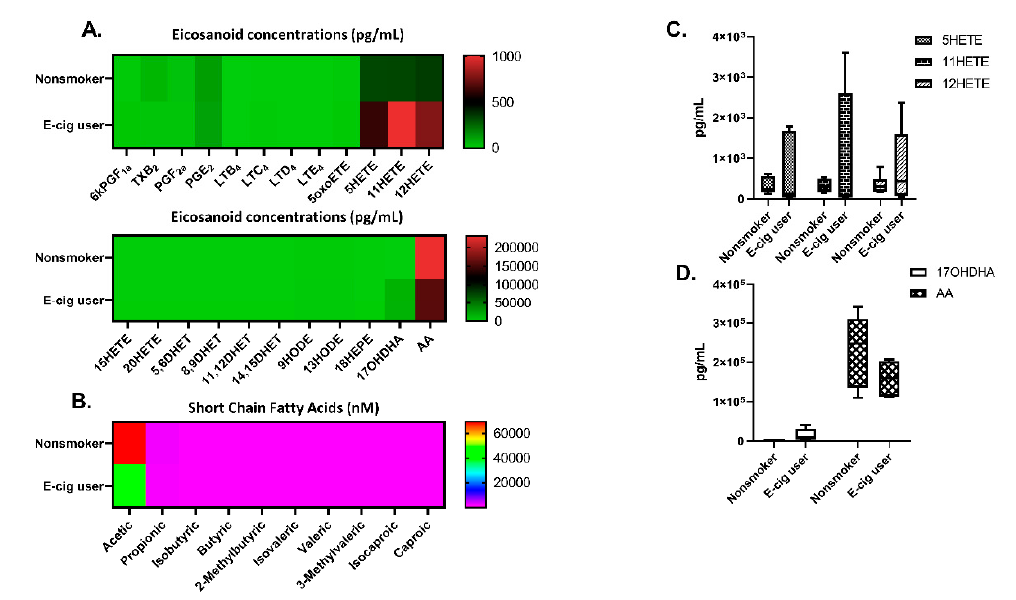
Figure 9. Plasma eicosanoids, oxylipins, short-chain fatty acids in nonsmokers and e-cig users. ( A ) Heat map generated from relative quantification by LC-MS / MS of eicosanoids, oxylipins, and ( B ) short-chain fatty acids in plasma from nonsmokers and e-cig users. ( C ) 5HETE, 11HETE, and 12HETE levels in plasma ( D ) 17OHDHA and AA in plasma ( n = 6 / group). p > 0.05 vs. nonsmokers were considered insignificant and were not denoted with asterisks.